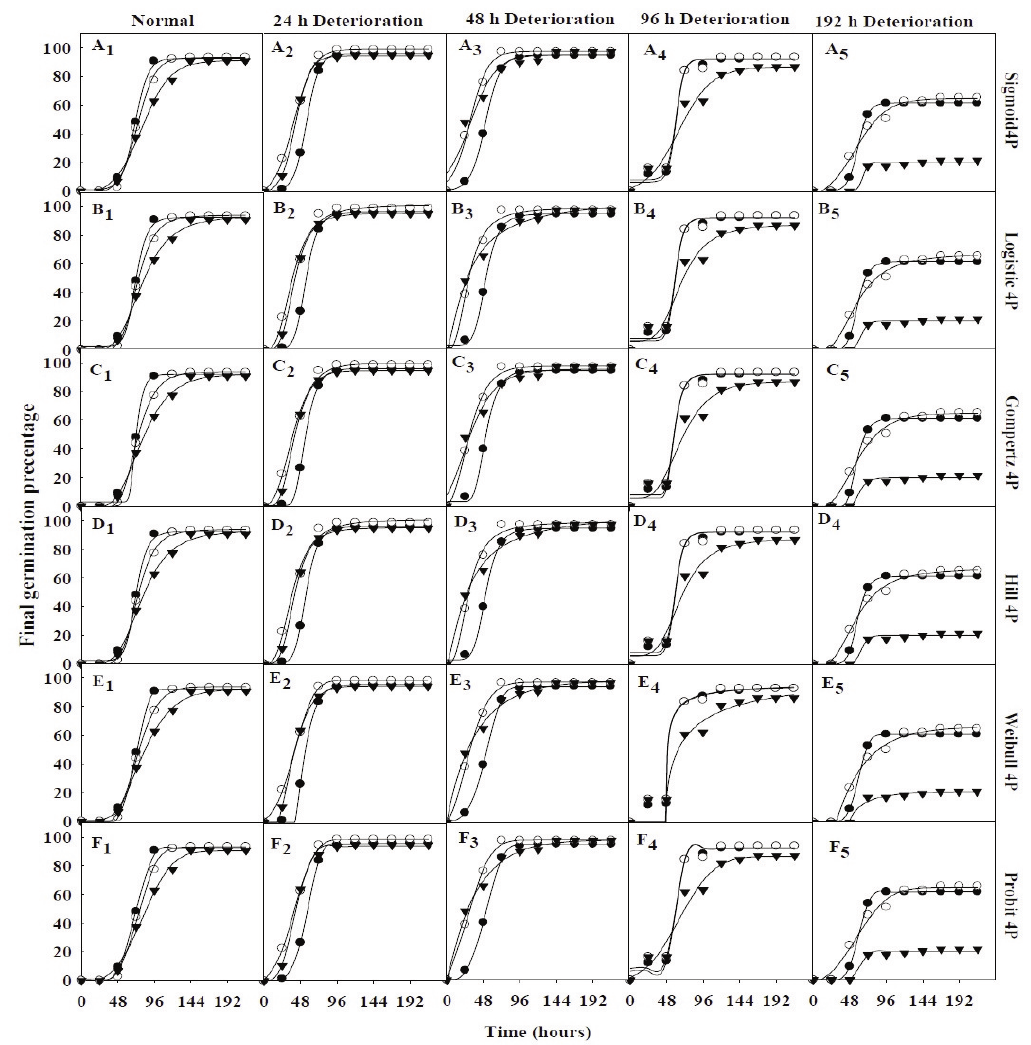
Fig. 2 - Model fit function 4 parameter of germination ecotypes okra ( Abelmoschus esculentus L.) under dete- rioration condition. ● Ahwaz, ○ Isfahan and ▲ Mashhad